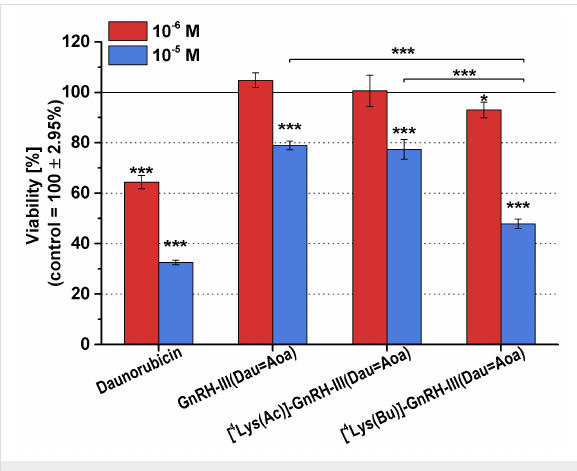
Figure 3: Short-term growth inhibitory effects of the conjugates and daunorubicin (Dau) on A2058 cells . The model cells were incubated with the compounds at 10 − 6 and 10 − 5 M concentrations for 6 h. The ‘Viability’ is expressed as a percentage of the control. Data shown in the figure represent mathematical averages of six parallels and ± S.D. values. The level of significance is shown as follows: *: p < 0.05; ***: p <